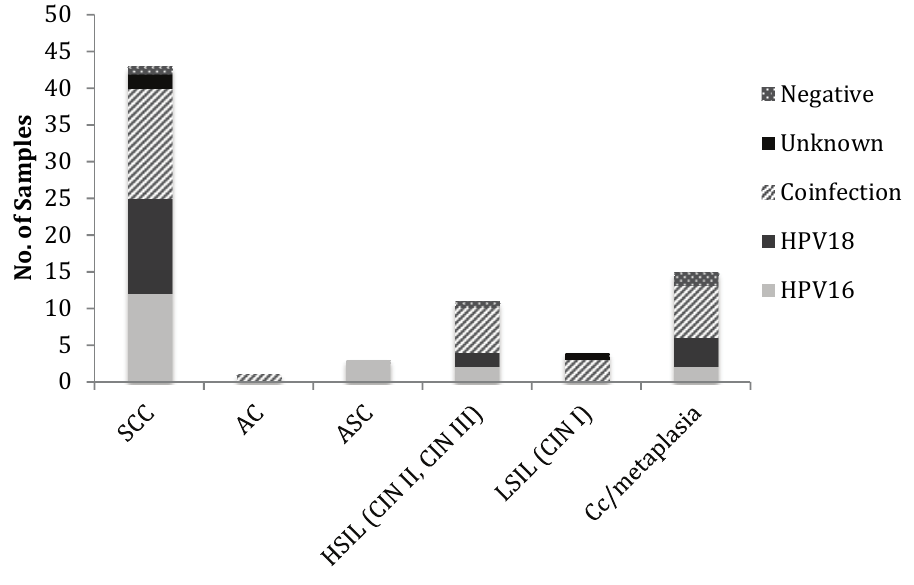
Figure 4. Genotypic distribution of HPV according to histopathological diagnosis. The incidence of SCC was higher and associated with HPV16, HPV18 and co-infection. The incidence of AC, ASC and LSIL were low. HSIL, chronic cervicitis (Cc)/metaplasia has a moderate incidence and were associated with higher incidence of co-infection in majority of cases as compared to HPV16 and 18 infection